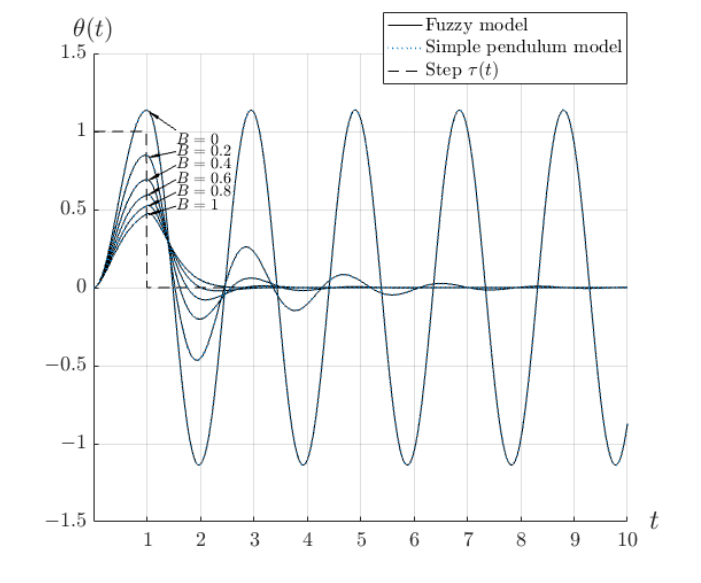
Figure 27. Simple pendulum